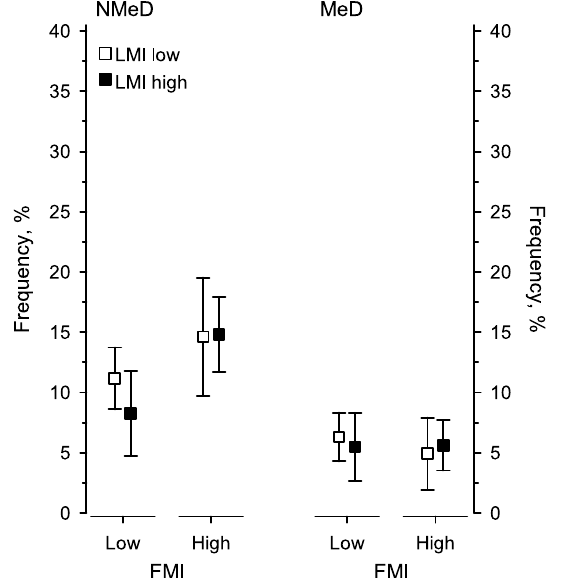
Figure 4. Frequency of depressive subtypes in relation to body composition as represented by mean and standard deviation. BDI beck depression inventory, FMI fat mass index, LMI lean mass index, MeD melancholic depressive symptoms, NMeD non-melancholic depressive symptoms. Models have been adjusted for age, sex, education, and fasting plasma glucose concentration. NMeD: FMI p = 0.008, LMI p = 0.38, interaction p = 0.31. MeD: FMI p = 0.83, LMI p = 0.93, interaction p =